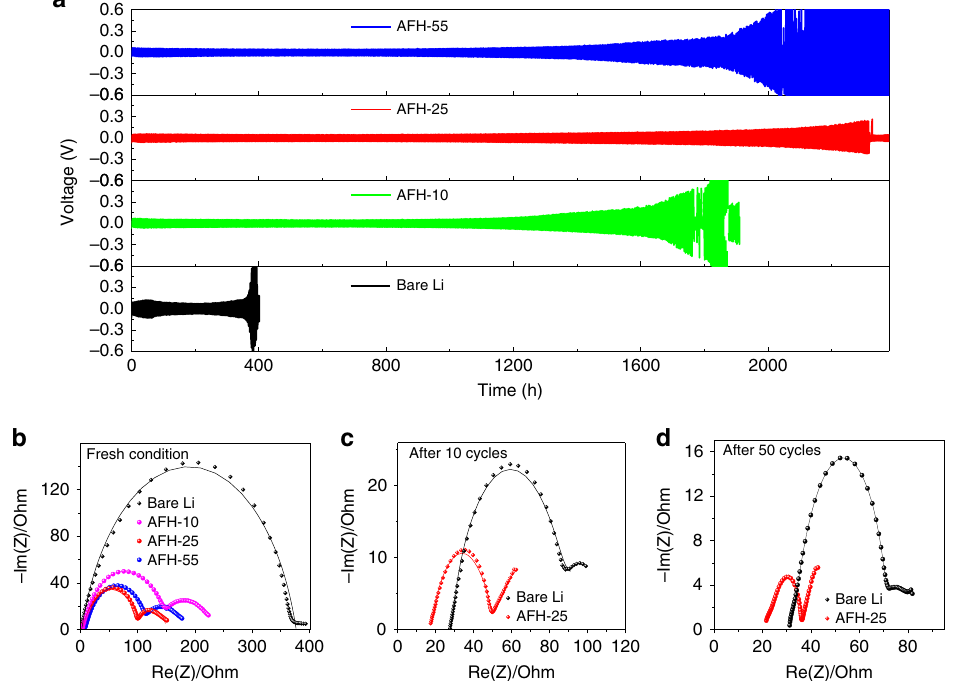
Fig. 3 Electrochemical symmetrical cell test and EIS measurement. a The voltage pro fi les of symmetrical cells with bare Li and different thickness of AFH SEI at a current density of 0.5 mA cm − 2 to achieve a capacity of 1 mAh cm − 2 . b Nyquist plot of bare Li and different thickness of AFH SEI symmetrical cells at fresh conditions. c , d Nyquist plot of bare Li and AFH-25 symmetrical cells after 10 cycles and 50 cycles at 0.5 mA cm − 2 ,